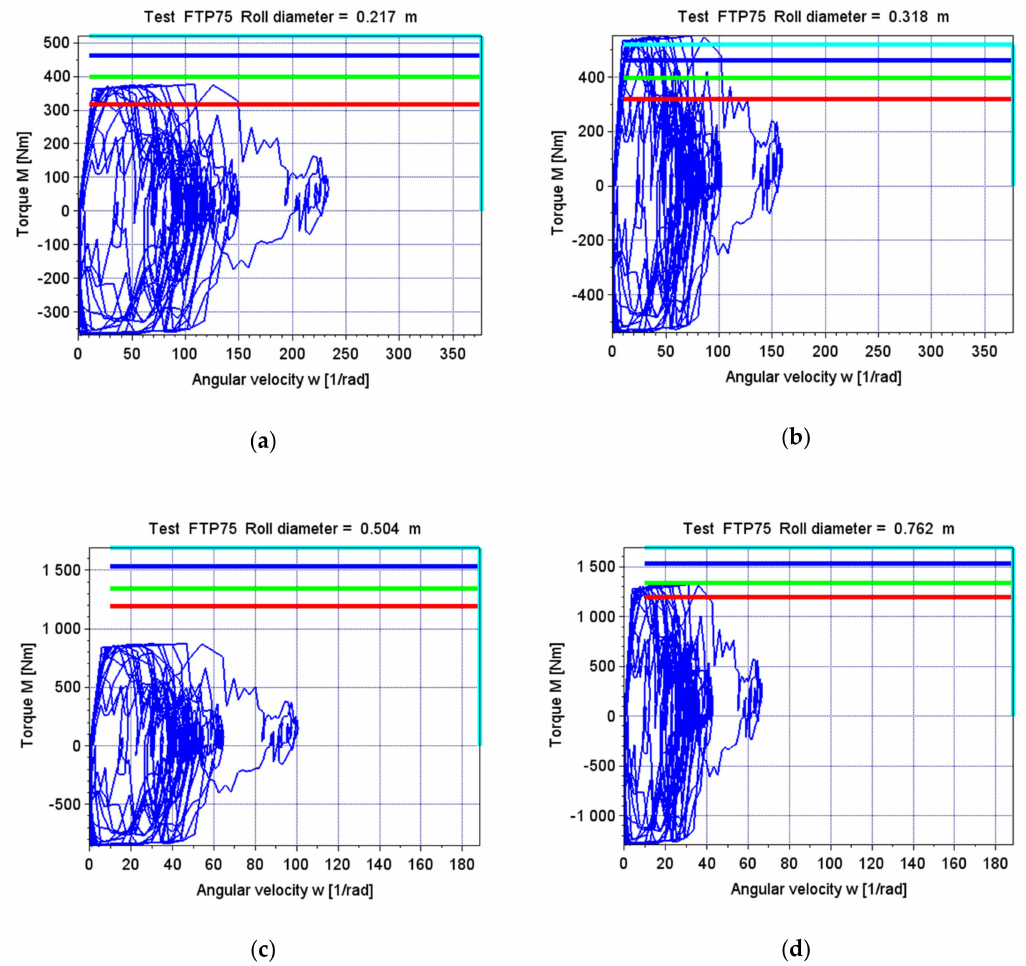
Figure 7. Simulation results for the FTP75 test in the form of rotational speed and torque of the chassis dynamometer brake for changes in the diameter of the brake rollers: ( a ) 0.217 m—ECP 34-1S / 2—Power 120 kVA red line; ECP 34-2S / 2—Power 150 kVA green line; ECP34-1L / 2—Power 174 kVA blue line; ECP 34-2L / 2—Power 196 kVA light blue line; ( b ) 0.318 m—ECP 34-1S / 2—Power 120 kVA red line; ECP 34-2S / 2—Power 150 kVA green line; ECP34-1L / 2—Power 174 kVA blue line; ECP 34-2L / 2—Power 196 kVA light blue line; ( c ) 0.504 m—ECO38 1S4 A—Power 225 kVA red line; ECO38 2S4 A—Power 253 kVA green line; ECO38 3S4 A—Power 289 kVA blue line; ECO38 1L4 A—Power 319 kVA light blue line; ( d ) 0.762 m—ECO38 1S4 A—Power 225 kVA red line; ECO38 2S4 A—Power 253 kVA green line; ECO38 3S4 A—Power 289 kVA blue line; ECO38 1L4 A—Power 319 kVA light blue